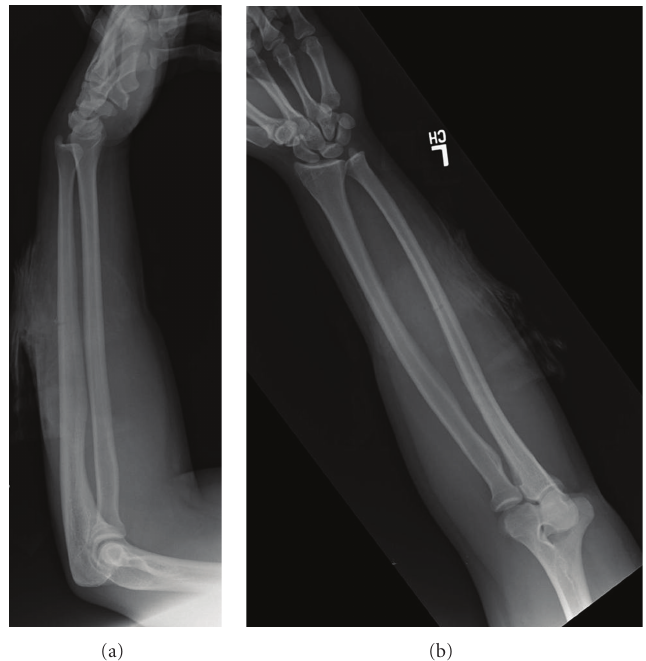
Figure 2: Preoperative (a) anteroposterior and (b) lateral forearm radiographs of 17-year-old right hand dominant male who was struck with a machete on his left dorsal forearm.